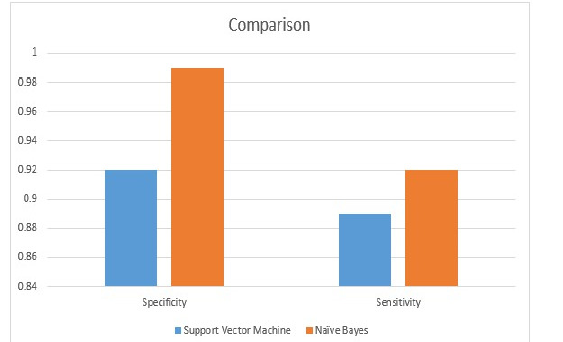
Fig. 18: Sensitivity and Specificity Table 4: 10-fold Cross Validation for Naïve Bayes classifier